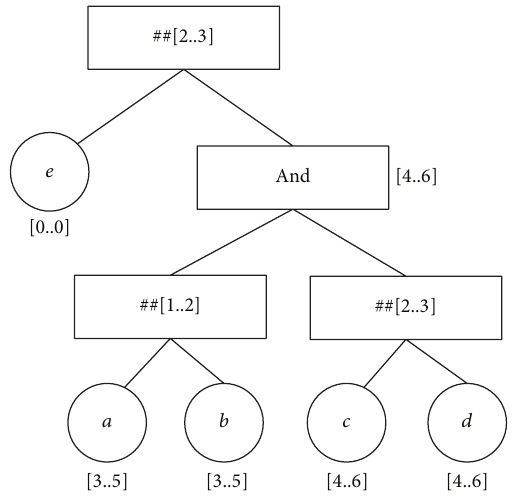
Figure 2: Sequence depth parsing